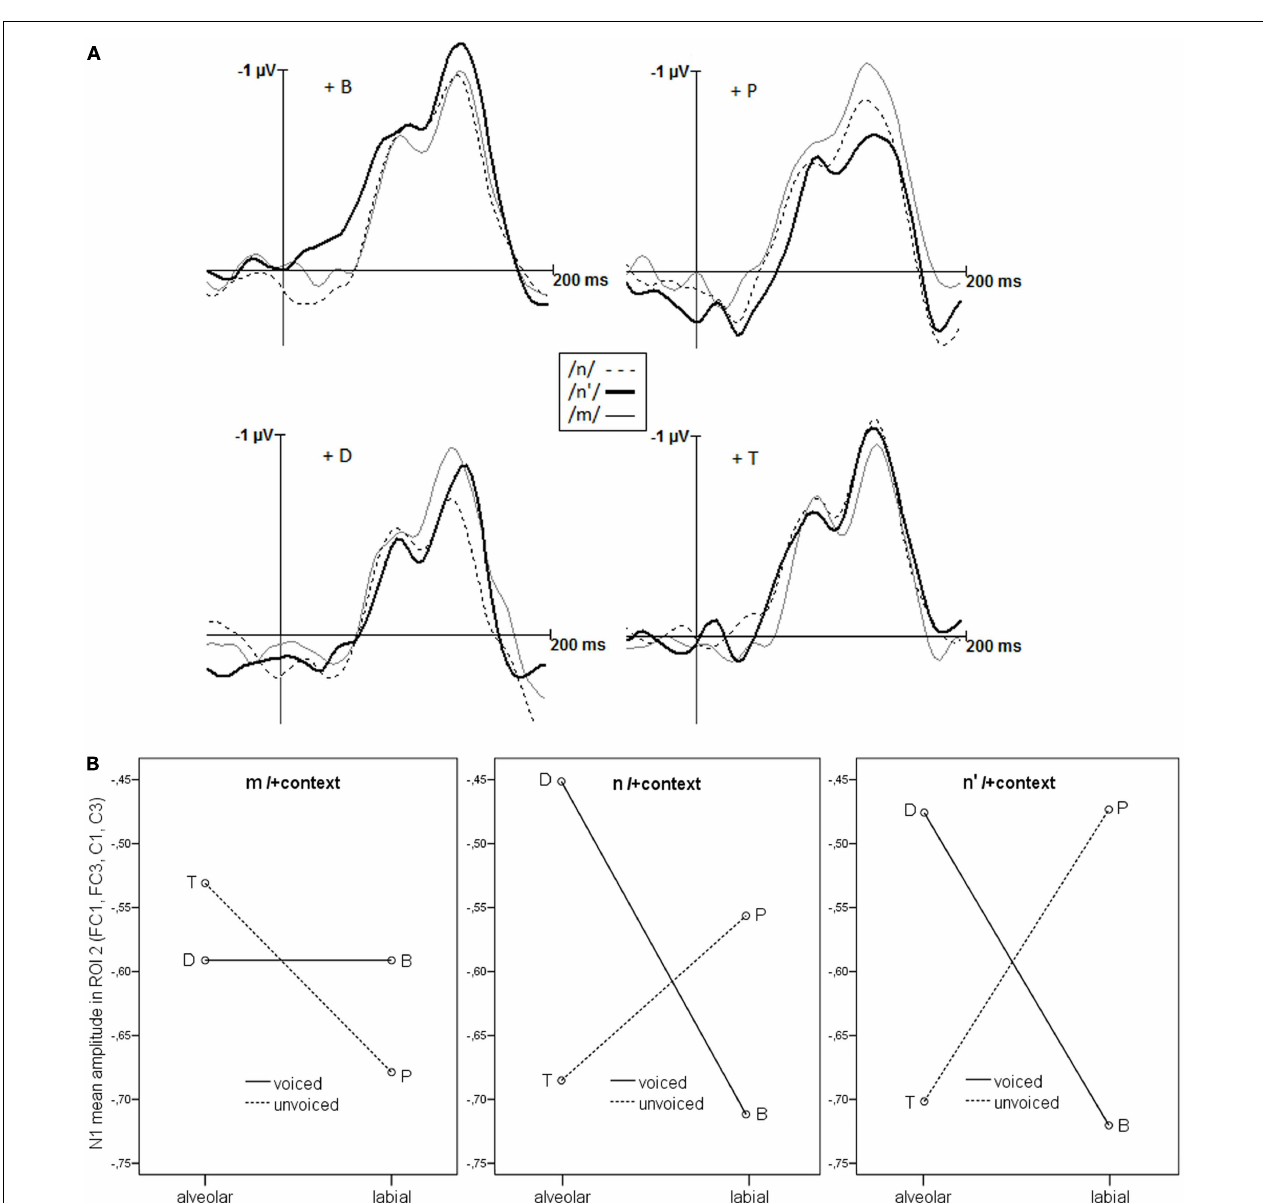
FIGURE 4 | (A) The N100s (in µ V) elicited by the nasals in context, as a function of the context phoneme (labeled P,T, B, D).The width of the N100 window is 110ms. Only − 40ms of a − 200ms baseline are shown here. (B) The N100 (mean amplitude in µ V) elicited by nasal/ + context stimuli. Context effects are modulated by the preceding